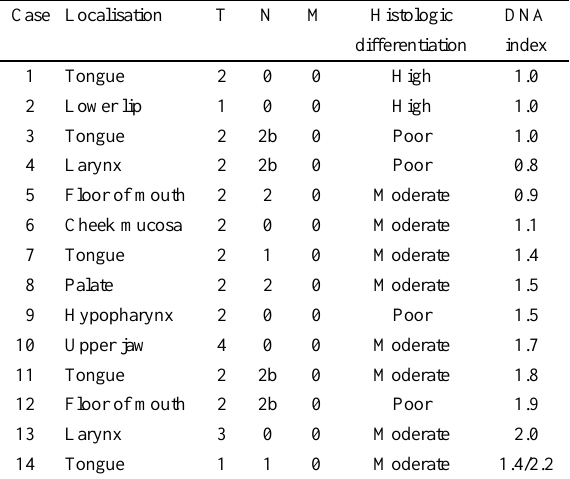
Clinical, histopathologic and DNA flow cytometric characteristics of the